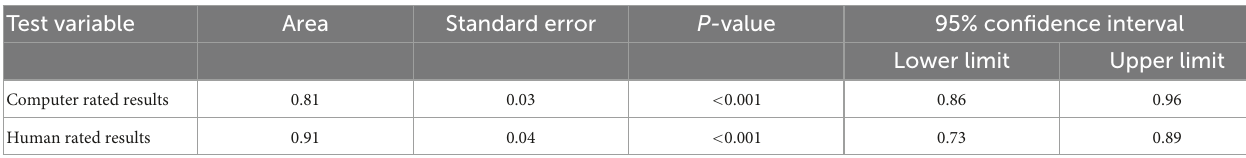
TABLE 3 Area under the ROC curves of ASD diagnosis from toddlers with ASD, DD, and TD based on the human- and computer-rated RTN results. Test